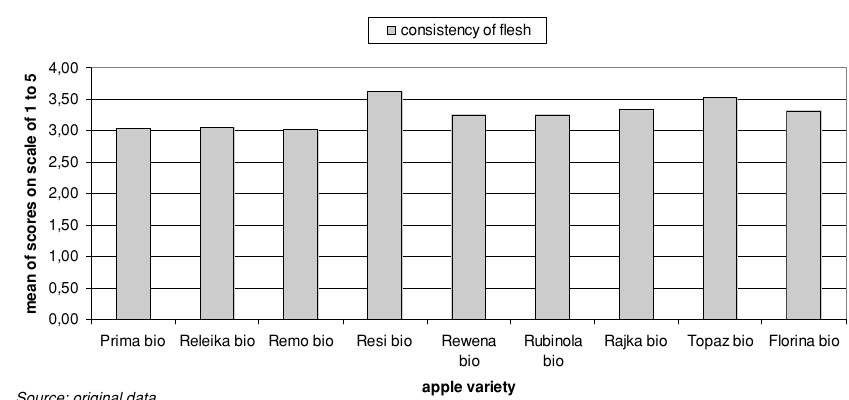
Figure 4: Mean scores given to the consistency of fruit flesh of the varieties.